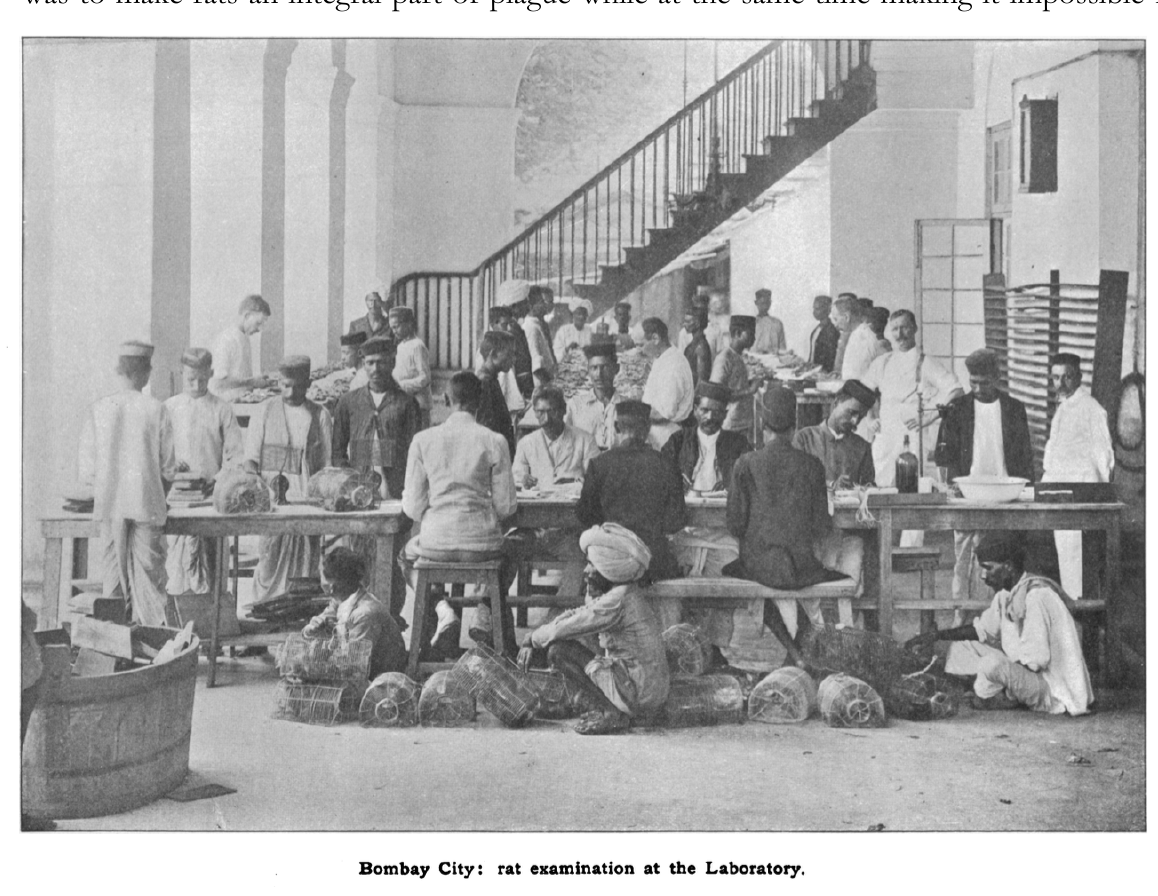
Figure 3. An illustration of the rat ‘processing’ Source: Plague Commission (1907b), plate